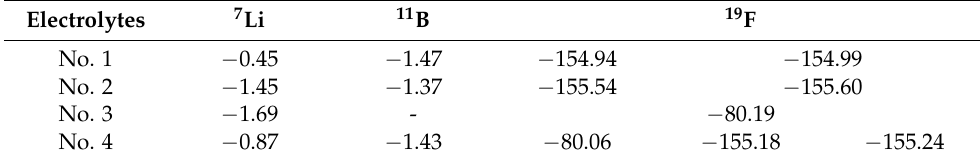
Table 4. Experimental 13 C chemical shifts of the solvent and electrolyte samples (in ppm).